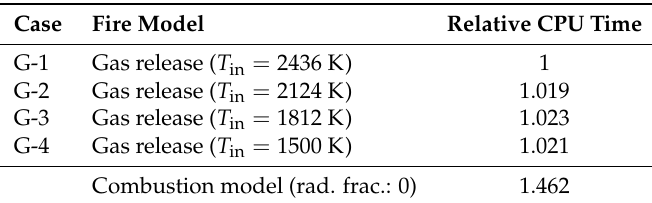
Table 4. CPU time (relative to Case G-1) in FDS simulations.